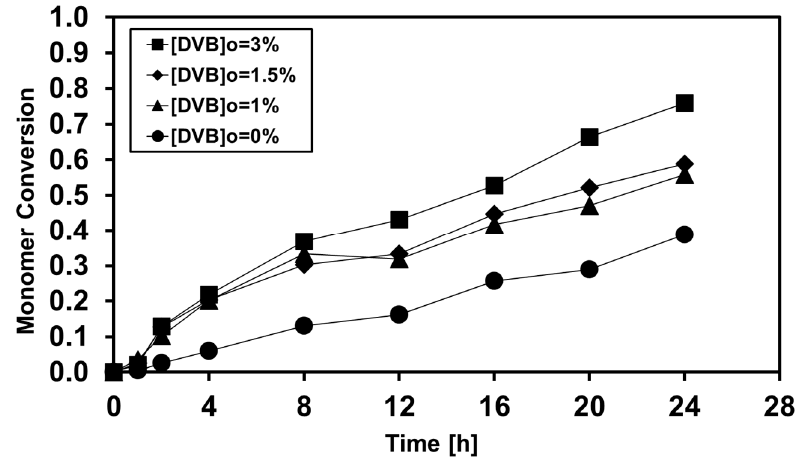
Figure 3. Effect of DVB content on conversion versus time for the NMC of STY/DVB in scCO 2 at [TEMPO]/[BPO] = 1.1, T = 120 °C, and P = 207 bar.